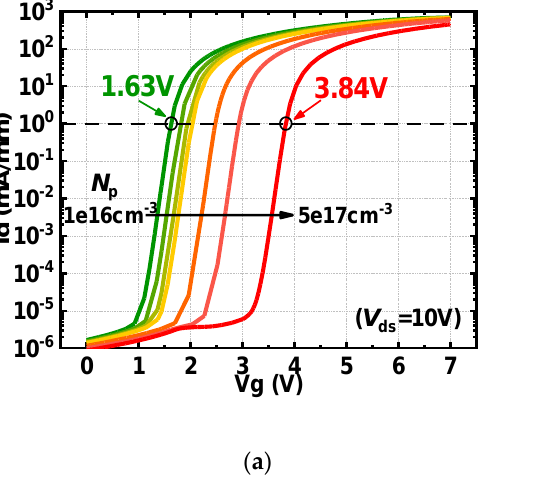
Figure 4. ( a ) V TH modulation of HG − UTB HEMTs by varying N p ; ( b ) energy band diagram under the gate region at AlGaN/GaN heterojunction with various N p .